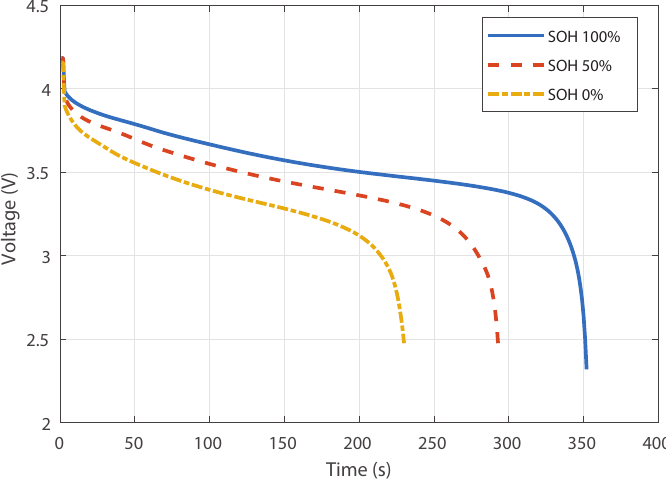
Figure 1. Battery discharge curves at constant load current of 2.0